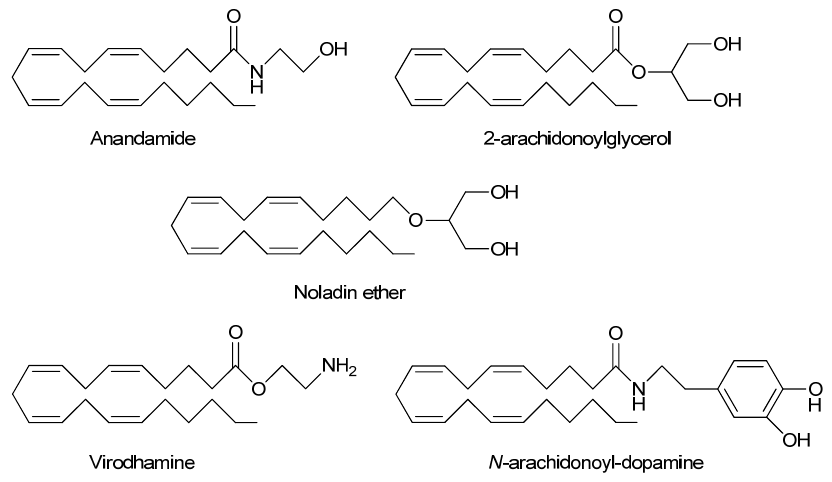
Figure 1. Chemical structures of proposed